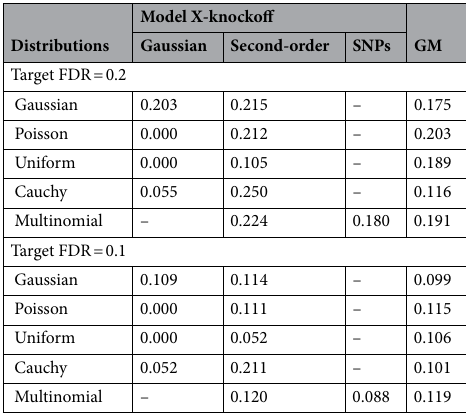
Table 1. The false discovery rate when the explanatory variables follow different distributions (n = 500).